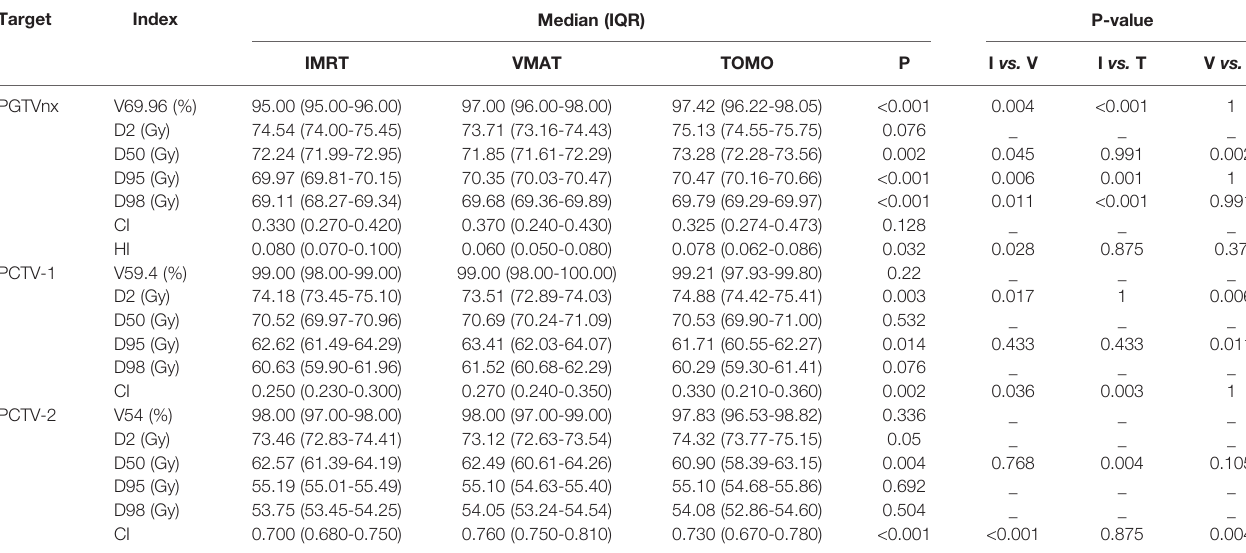
TABLE 5 | Comparison of targets in T 1-2 NPC patients.